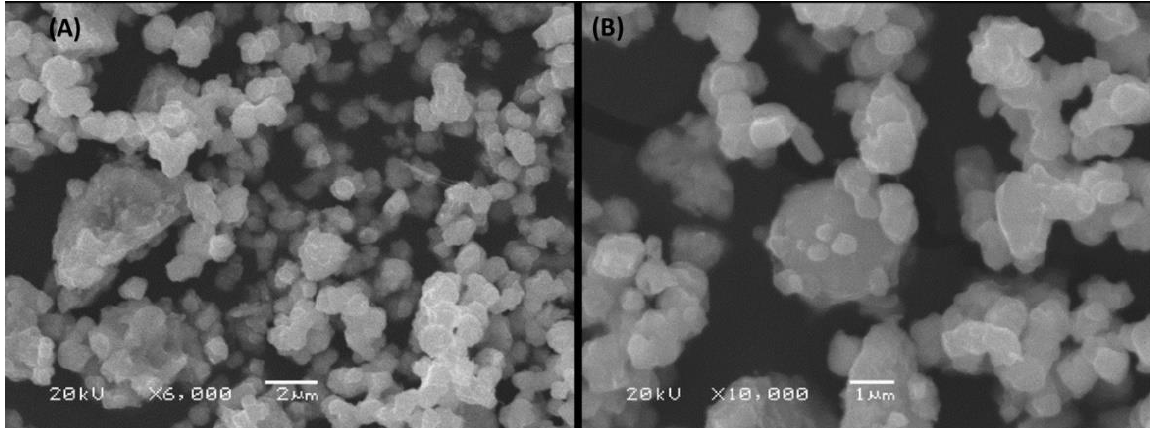
Figure 1. SEM of stabilized nano-selenium with magnifications of 6000 ( A ) and 10,000 ( B ).